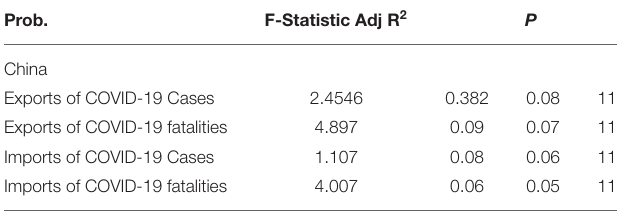
TABLE 5 | COVID-19’s influence on Chinese exports and imports: a causality test.